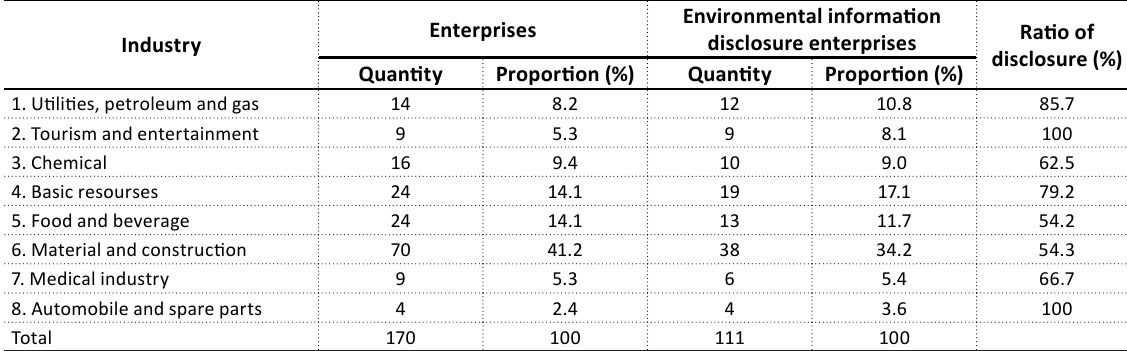
Table 2. Industry distribution in the research